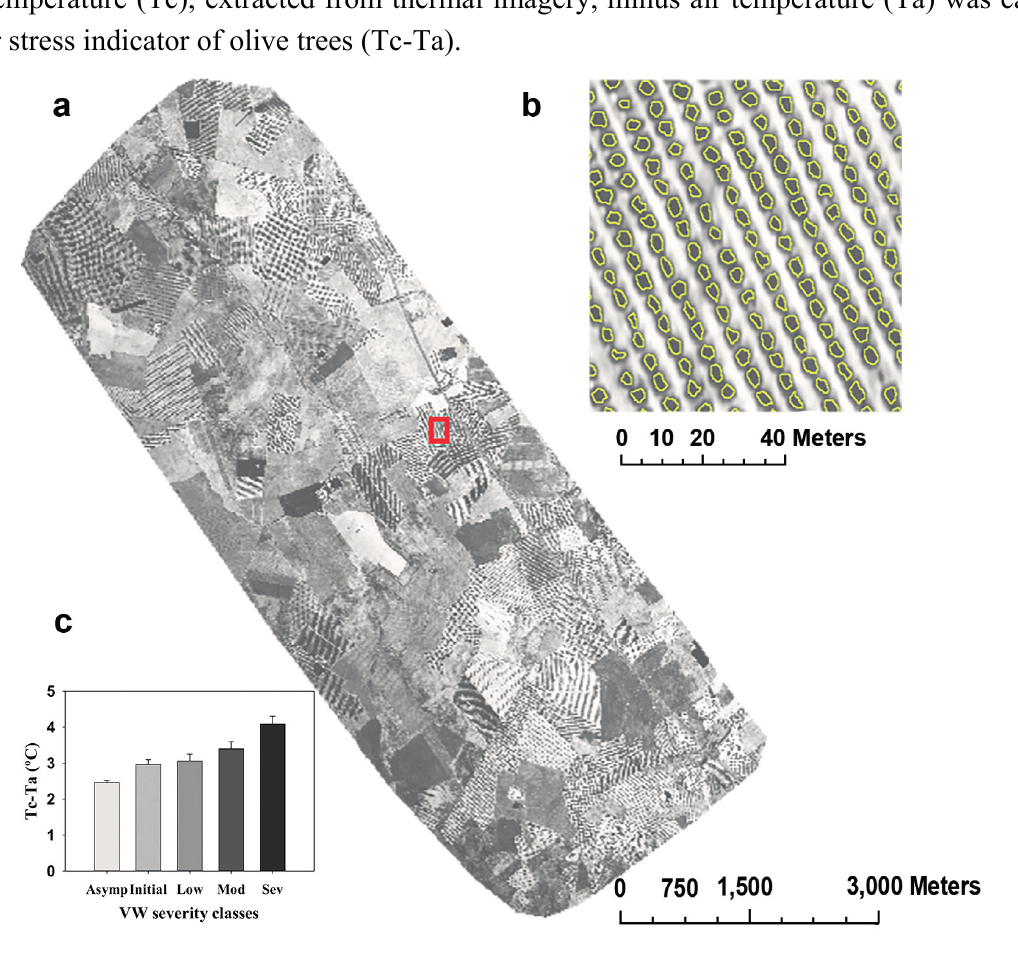
Figure 3. Thermal mosaic ( a ) obtained with the thermal camera on board the manned platform at 63-cm resolution, enabling pure olive crown identification ( b ). Pure olive crowns were identified using automatic object-based crown detection. Mean crown normalized temperature (Tc-Ta) calculated from thermal imagery is shown for every Verticillium wilt severity class in ( c ). Mean values of Tc-Ta were supported by the data of the 9 plots, consisting of 510, 98, 64, 46 and 38 olive trees which correspond to asymptomatic, initial, low, moderate and severe severity classes, respectively. Error bars indicate standard errors. Red square ( a ) is shown in detail in ( b